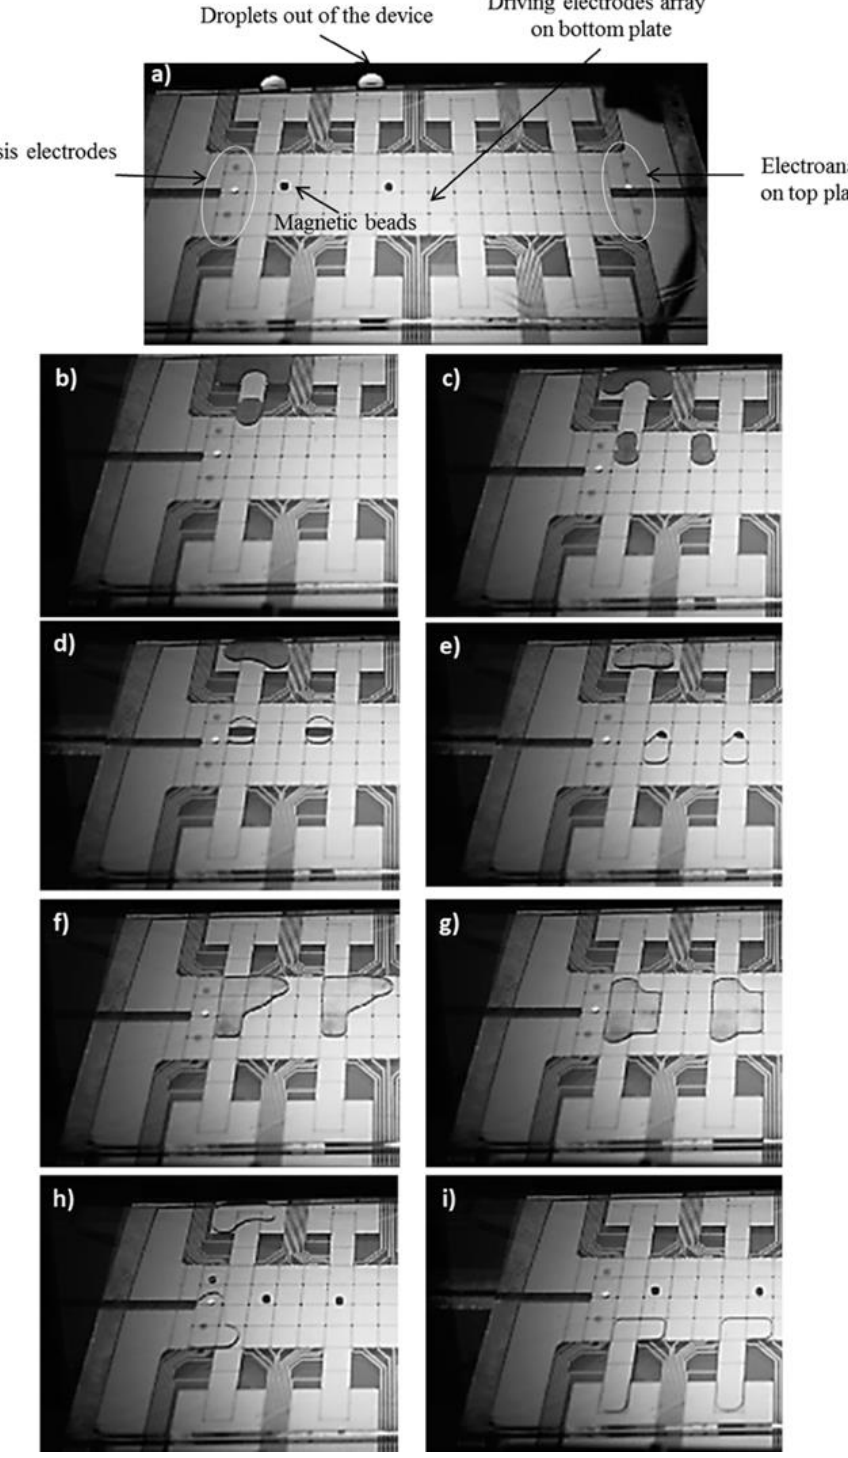
Figure 6. Micro-graphs showing an example immunoassay on a two-plate EWOD DMF chip (reproduced with permission from [23]);( a – c ) dispensing and transport of magnetic bead, antibody and blocking protein mixture; ( d , e ) trapping of magnetic beads and splitting of unused solvent mixture using a magnet; ( f , g ) washing and resuspension of the functionalized beads; ( h , i ) elution of the captured antibody target from the magnetic beads and electro analysis using the top plate measurement